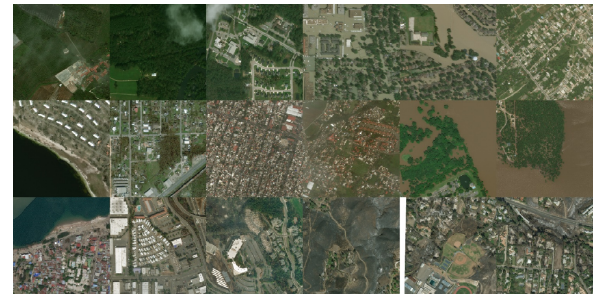
Figure 2. Post-disaster xView2 images